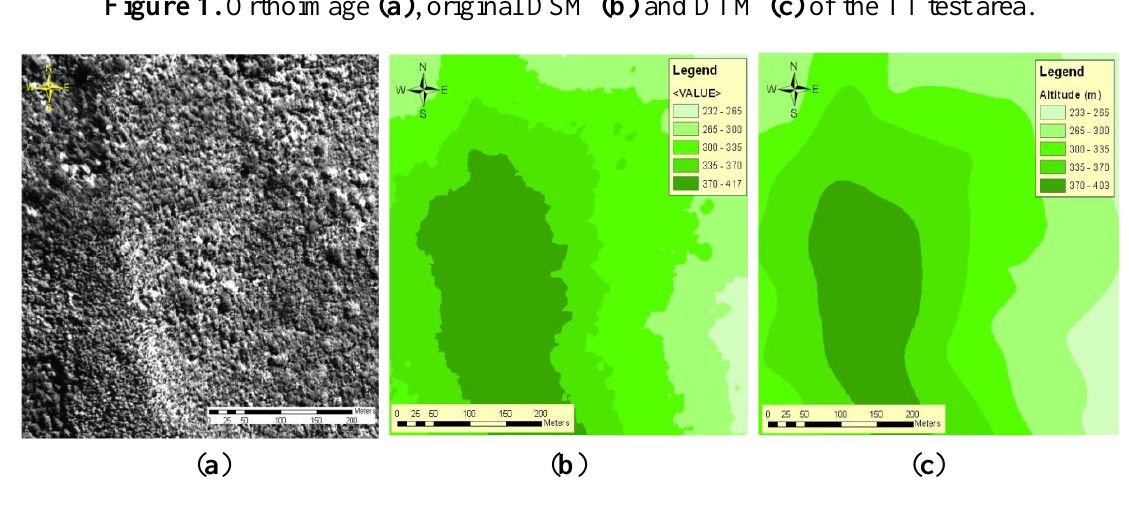
Figure 2. Perimeter of the area and nine sample points of T1 test